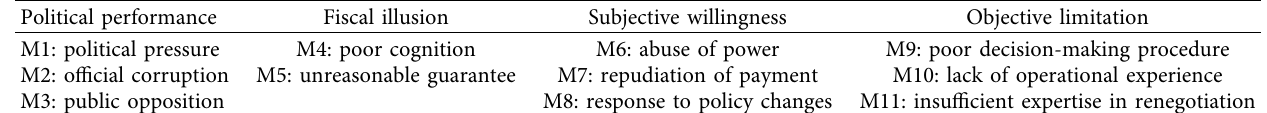
Table 1: Logic of credit default for LPSs in Government-Pay PPP projects.